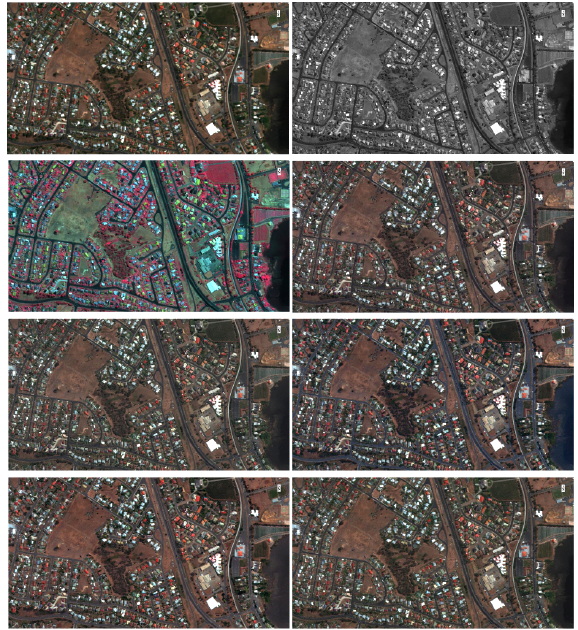
Figure 9. Example images to test the feasibility of the VQAP; left to right and top down: Original MS, original PAN, Brovey